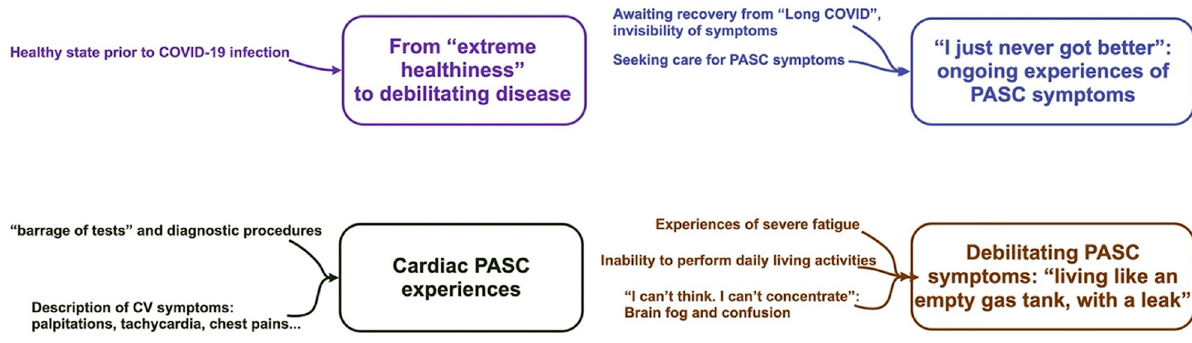
Fig 2. Graphical coding tree and emergent descriptive